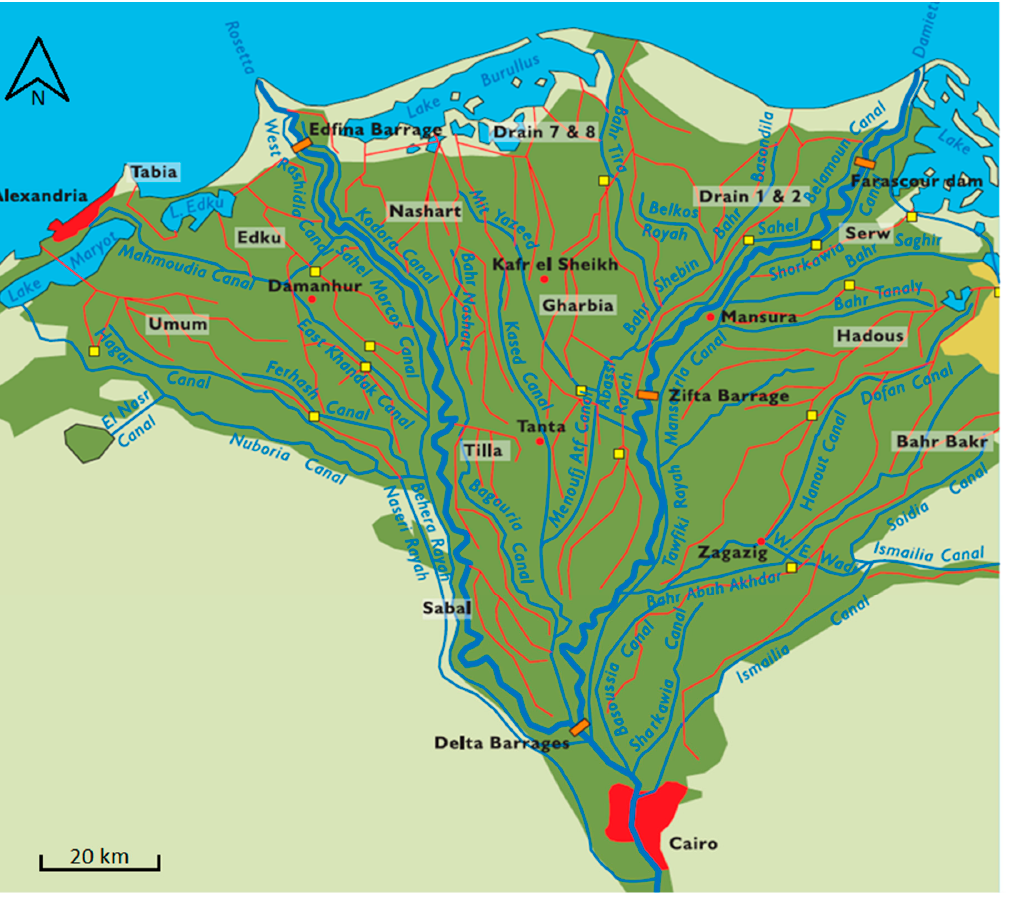
Figure 2. The Nile water system. Legend: The Nile River (thick blue lines), the supply canals (thin blue lines), and the irrigation drainage canals (red lines). Source: Reproduction from [23].